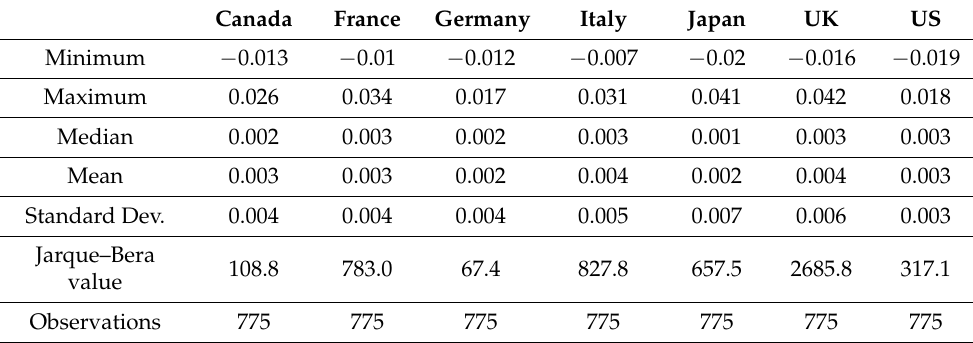
Figure 1. Inflation rate of the G7 countries, 1956–2020. Table 1 presents the summary statistics of the inflation rate indices. The highest disinflation was found in Japan (Min = − 0.02) and the highest inflation was found in the United Kingdom (Max = 0.042). The average inflation was the highest in Italy and in the United Kingdom (Mean = 0.004). Inflation was the most consistent in the United States (S.D. = 0.003). Table 1. Summary statistics of the inflation rate of G7 countries, 1956–2020.